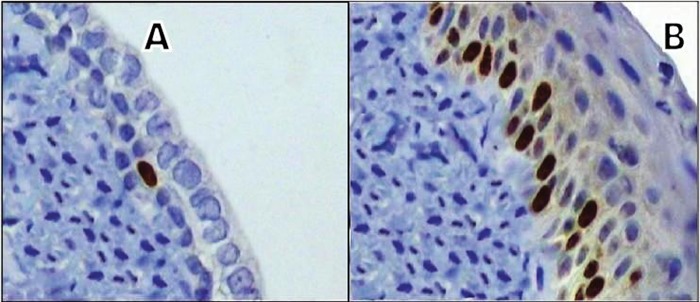
Photomicrograph of a histological section of the vaginal epithelium of castrated rats showing a greater concentration of Ki-67-stained nuclei in the experimental group (tamoxifen) (B) compared with the control group (A) (original magnification x400).